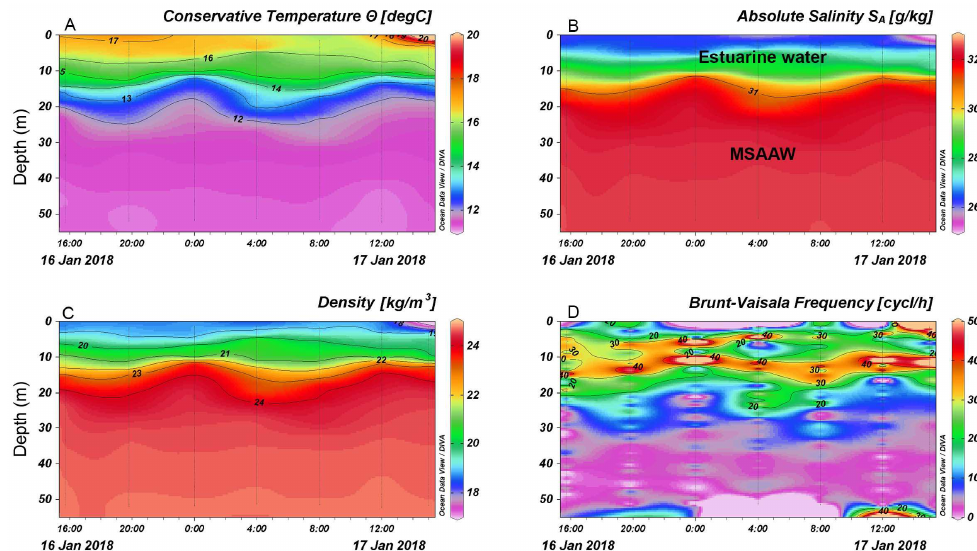
Figure 3. ( A ) Conservative temperature; ( B ) absolute salinity profiles, ( C ) water density; ( D ) Brunt–Vaisala frequency estimates at the oceanographic buoy station in Reloncaví Sound. Dotted lines correspond to CTD profiles.